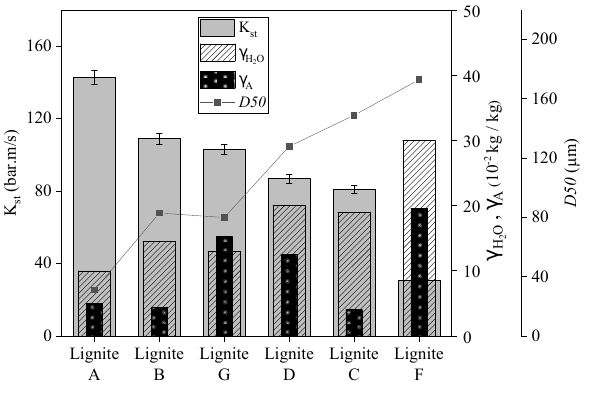
Figure 5. K st in descending order, first right axis: moisture and ash content, second right axis: median particle